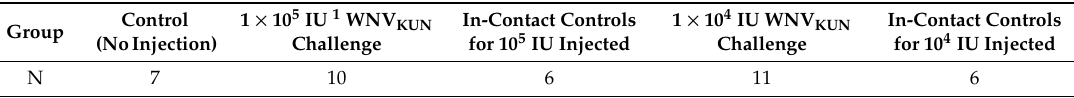
Table 1. West Nile Virus, Kunjin strain (WNV KUN ) experimental infection trial groups description and